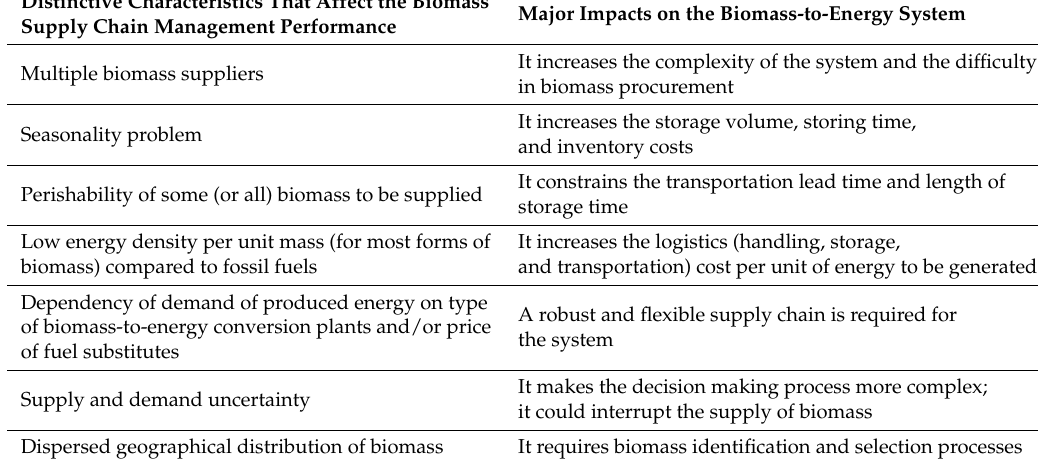
Table 1. Major characteristics of the biomass supply chain and the related impacts on biomass- energy